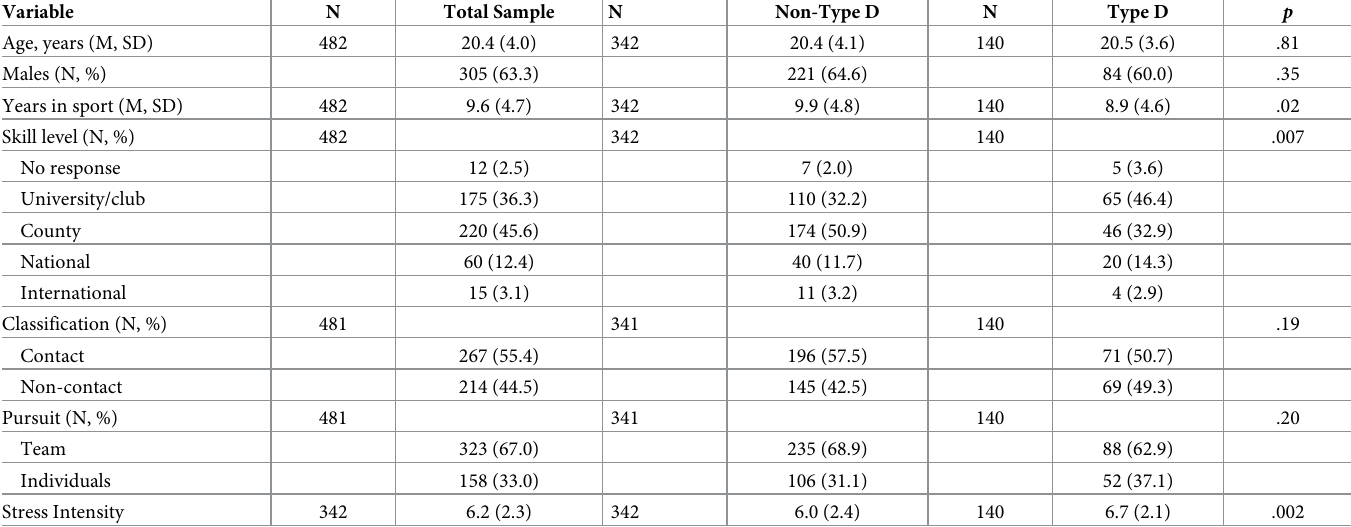
Table 1. Sample characteristics of the athlete participants in study 1 and difference between Type D and non-Type D